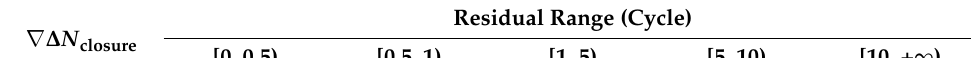
Table 4. The statistics of ∇ ∆ N closure .